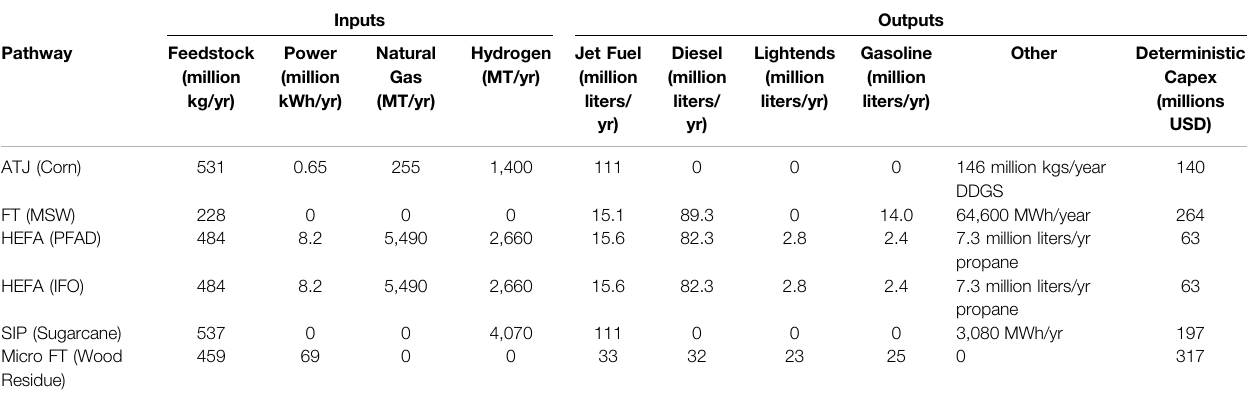
TABLE 1 | Pathway average input and